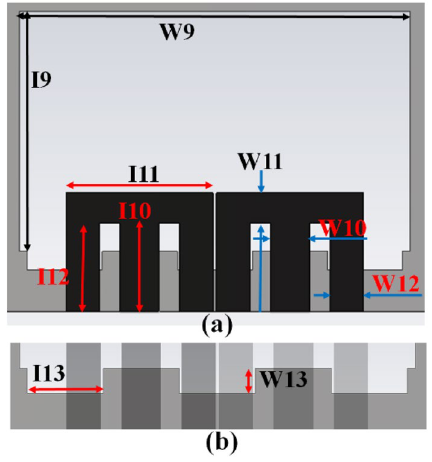
Figure 11. Detail dimension of Ant 5–8 ( a ) top, ( b ) ground structure.